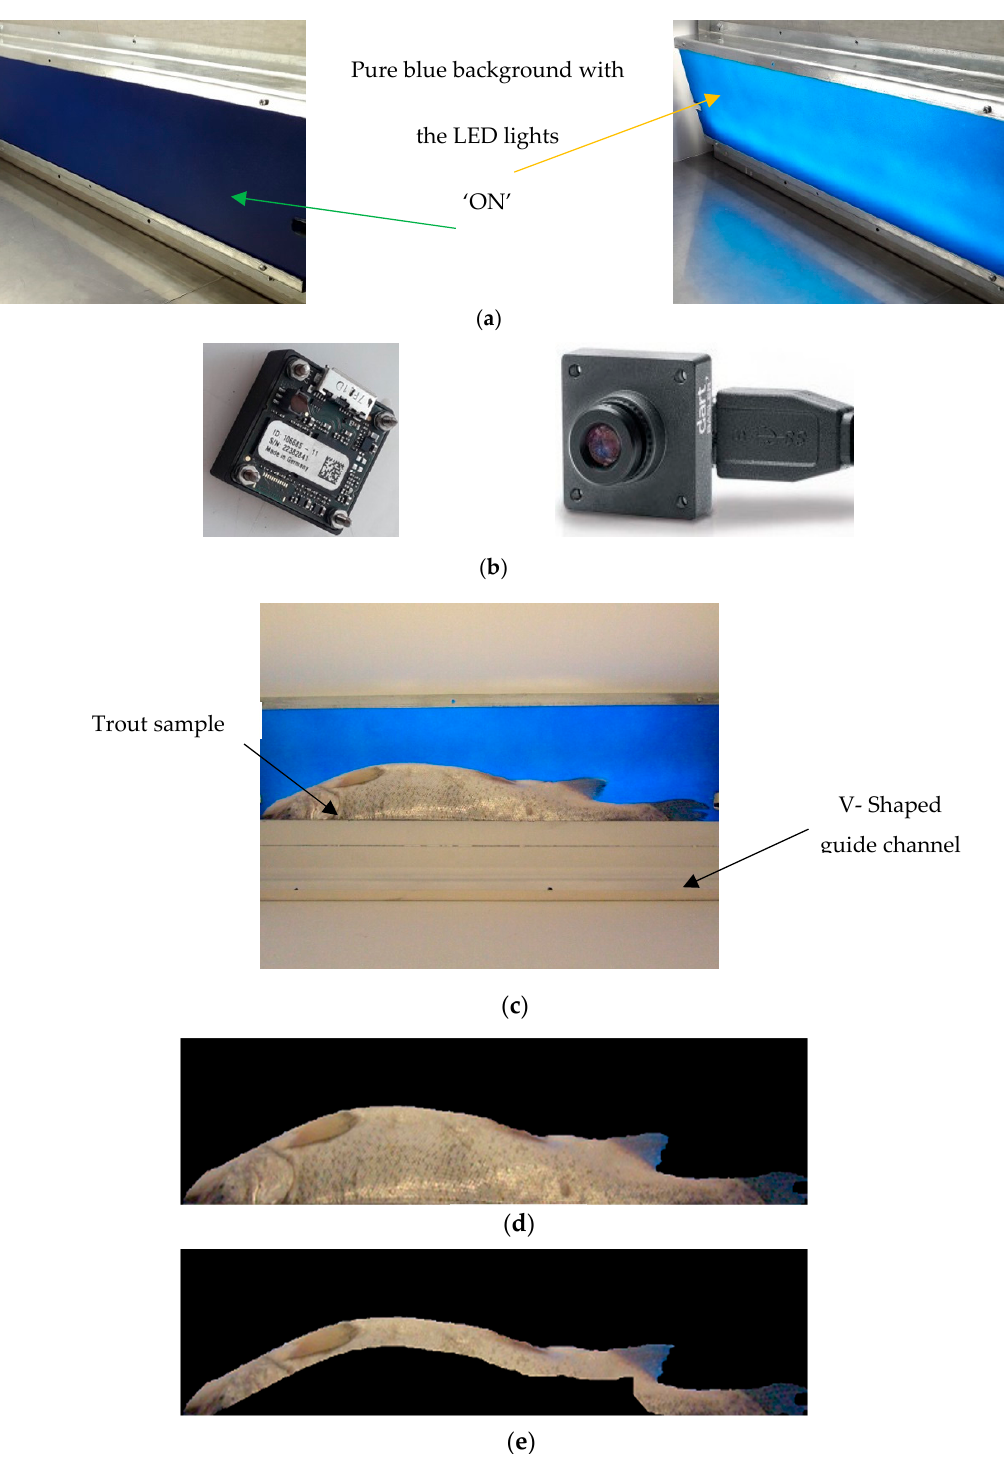
Figure 1. The image processing setup: ( a ) pure blue background, ( b ) the video camera, ( c ) inside of the imaging case with the sample, ( d ) segmented fish, and ( e ) trout fin shear to define the cutting points and functioning lengths. The cutting points and extracted dimensions are presented in Figure 2. The head and belly-cutting regions will be considered as the operational points of the system. L 1 to L 4 are head-cutting point, belly-cutting start point, the body length without tail, and total length, respectively. The operational width of the trout is shown as